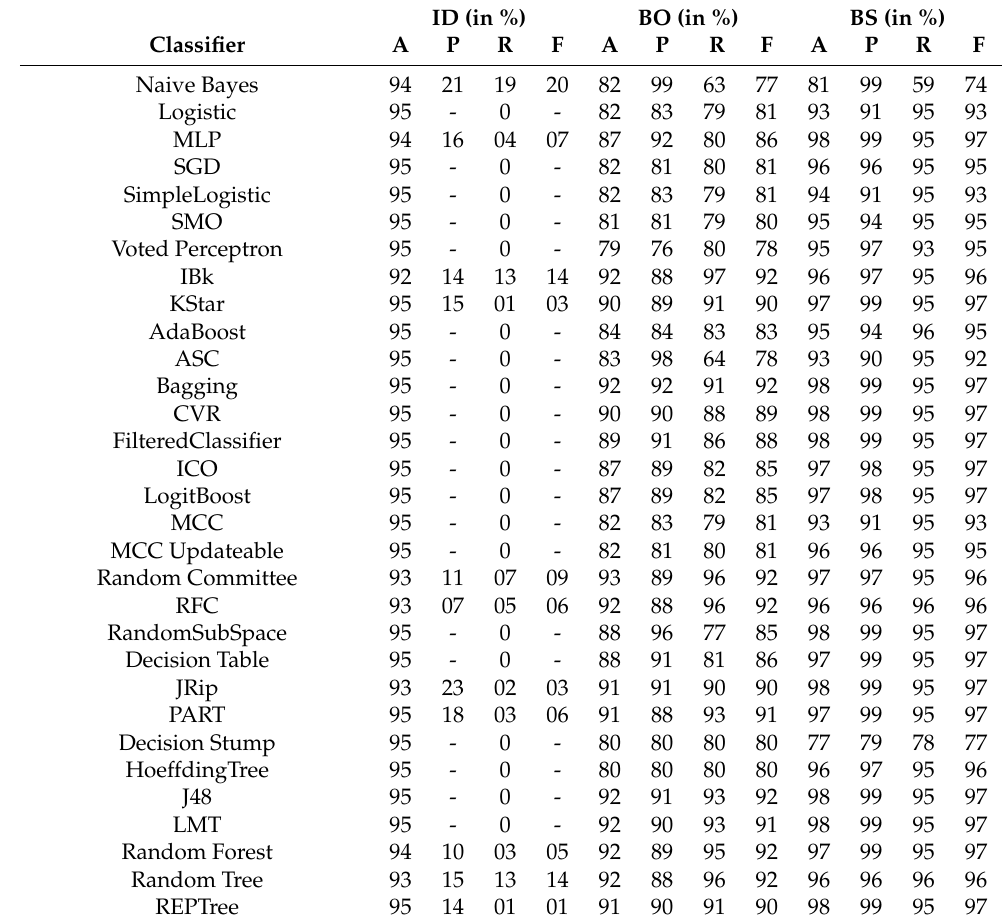
Table 2. Performance evaluation using different classifiers and different datasets.